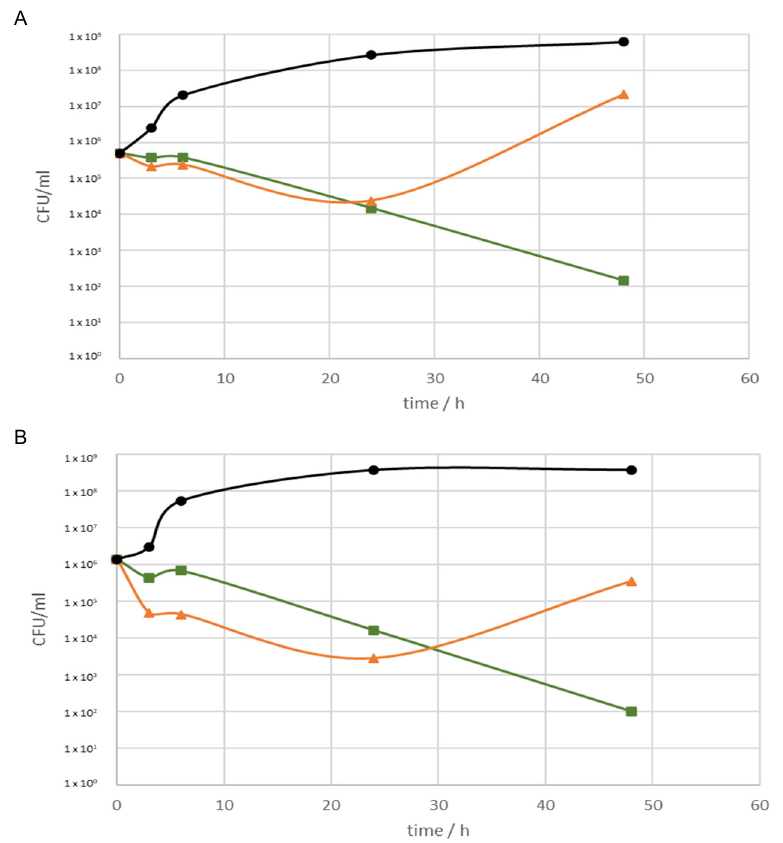
Figure 1. Growth inhibition by Ci_SFE opt and Ci_SFE pur at a concentration of 5 mg/mL against ( A ) S. aureus , and ( B ) S. aureus MRSA. Green, Ci_SFE pur ; orange, Ci_SFE opt , black, microbial control. Table 4. Antibacterial activities of Ci_SFE pur and Ci_SFE opt (mg/mL). MIC, minimal inhibitory concentration; MBC, mini- mal bactericidal concentration.